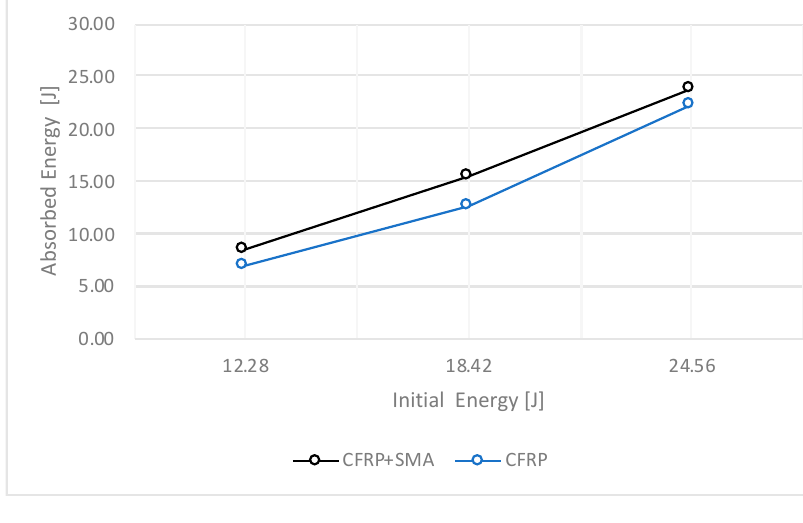
Figure 5. Energy history.